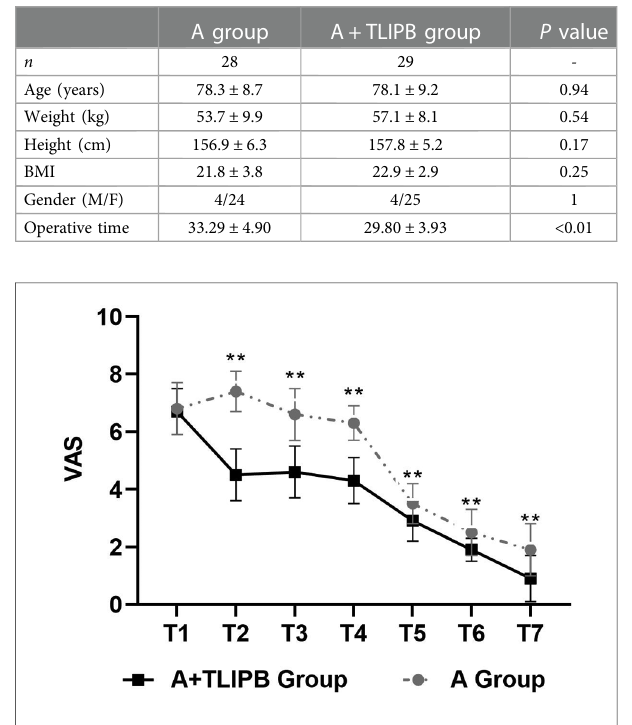
FIGURE 2 Pain level according to VAS score before surgery, trocar puncture into the vertebral body; balloon dilatation, bone cement injection, 1 h after surgery, 24 h after surgery, 7 days after surgery. The Wilcoxon – Mann – Whitney U -test was performed to detect the difference between the groups. ** P <0.001.